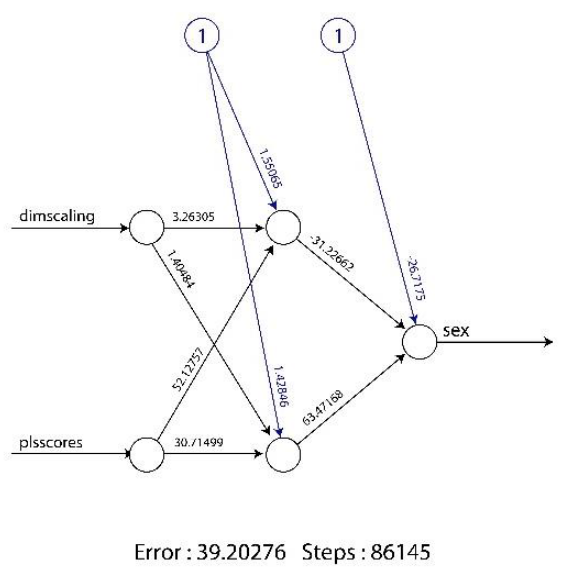
Figure 3. The artificial neural network created with the training sample. The discrimination threshold between males and females was set at 0.65 via ROC analysis (Figure 4), since this value optimizes true-positive and false-positive rates. Figure 4. ROC analysis of the discrimination accuracy of the ANN. A threshold of 0.65 was used to optimize true-positive and false-positive rates. The overall accuracy in classifying subjects by sex was found to be, respectively, 84% for the training sample and 80% for the test sample. The ANN yielded different sensitivity and specificity values for females and males (Table 1) in the test sample. The post-test probabilities (PPV and NPV) revealed that females showed a higher probability of being correctly positively classified as females, whereas males showed a higher probability of not being misclassified as females.